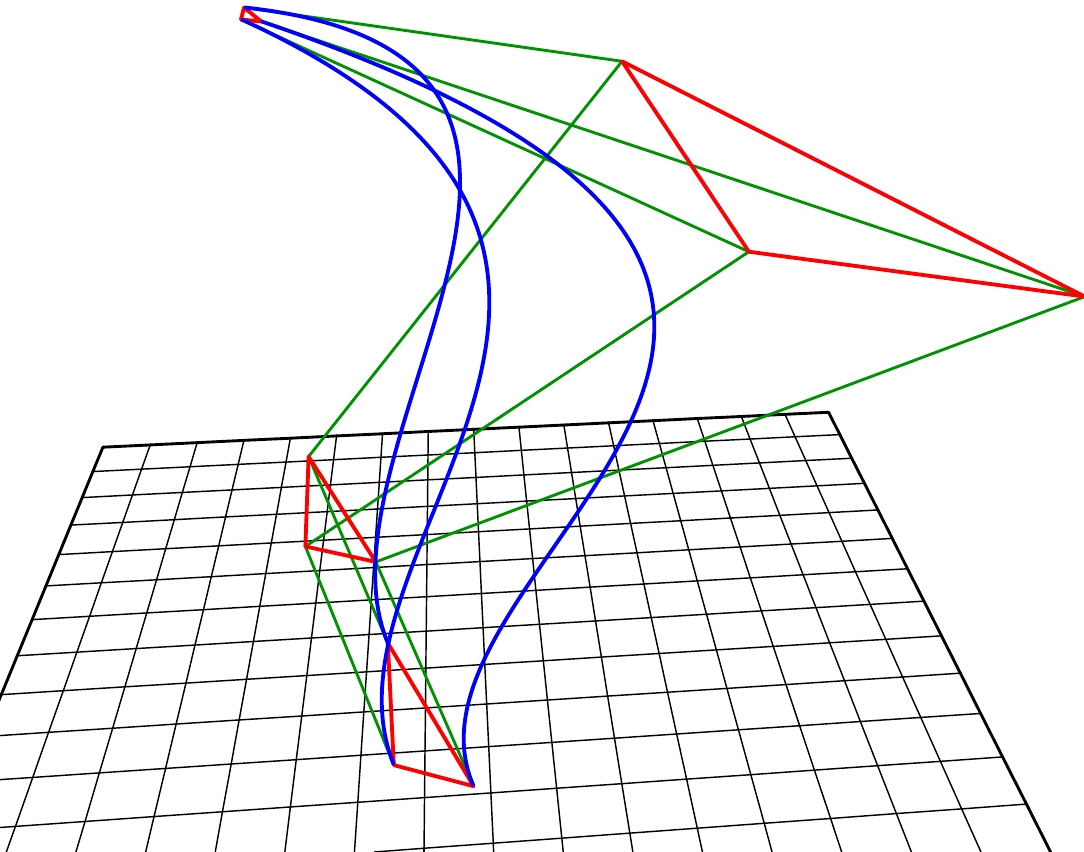
Figure 12. Scaled homothetic polylines (red) and splines drawn between nodes